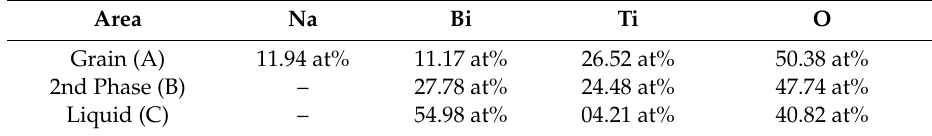
Energy dispersive spectroscopy (EDS) analysis results with 10 mol% Bi 2 O 3